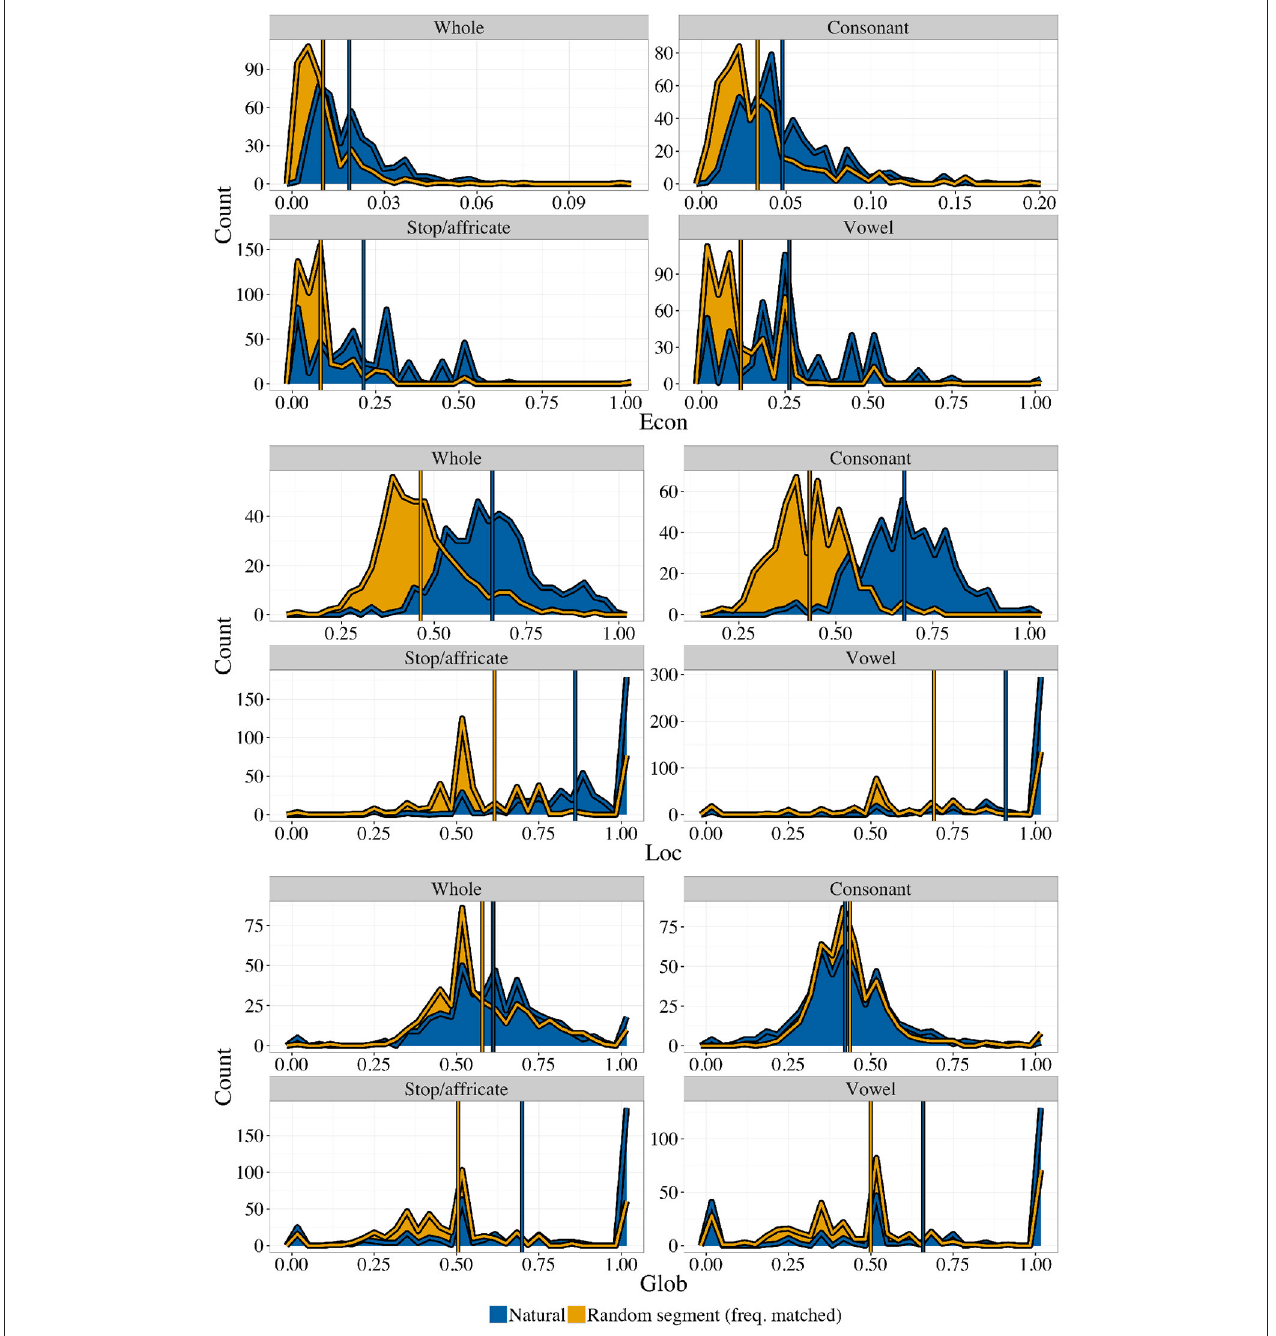
FIGURE 4 | Three geometric properties in natural vs. random inventories, taken from four defined subsets of the set of sounds in each inventory. Blue (darker) areas are natural inventories, orange (lighter) areas are random control inventories. Both histograms are highlighted with lines of the appropriate color. Means are shown as colored vertical lines on top of the histograms. Note that, while the scales for each graph are different for readability, the theoretical minimum is always zero and the theoretical maximum is always one.